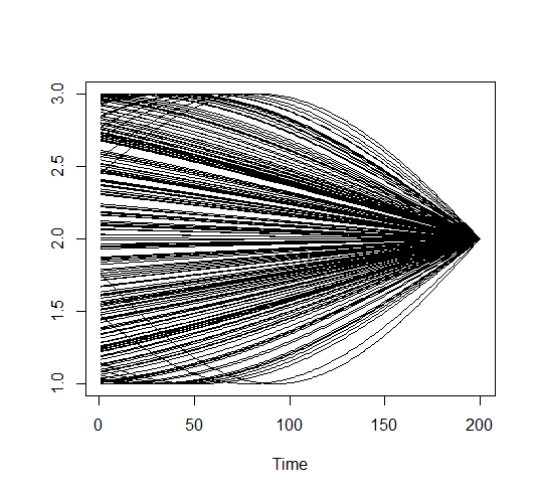
Figure 7: The curves X i =1, ... ,200 ( t ), t ∈ [0, 1].